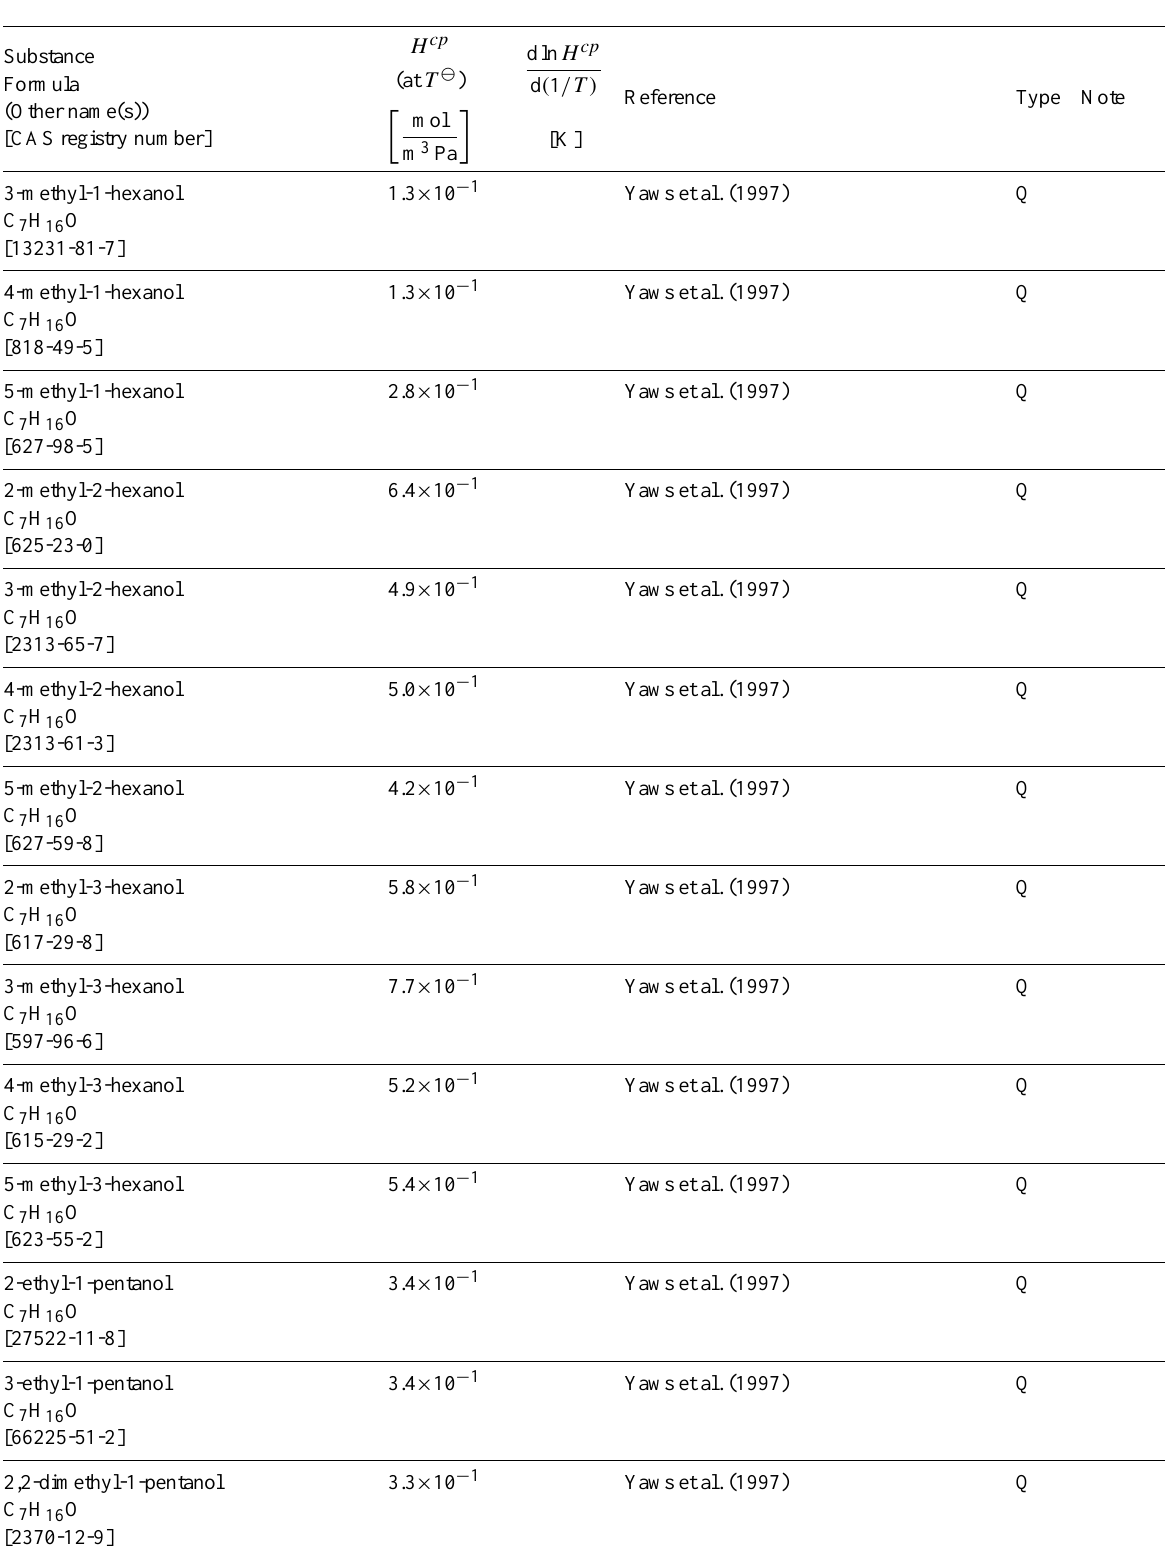
Table 6: Henry’s law constants for water as solvent